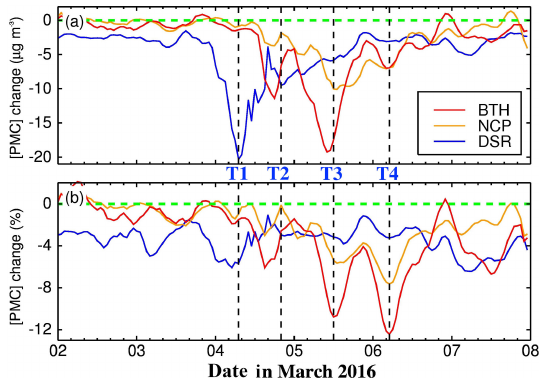
Figure 7. The hourly near-surface [PMC] change resulted from the land cover changes induced by ERPs from 2001 to 2013, includ- ing the temporal variations in (a) concentration and (b) percentage averaged at monitoring sites in the DSR, the NCP, and BTH (see Fig. 1b, including the provinces of Beijing, Tianjin, and Hebei, the heart of the NCP). The results refer to temporal variations between the REF case and the SEN-ERPs case (REF – SEN-ERPs).